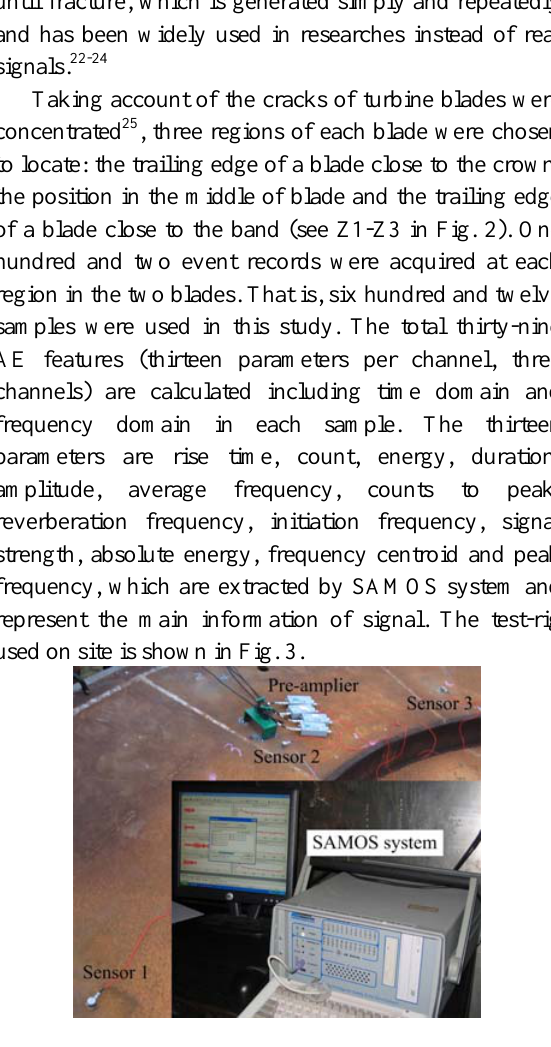
Fig. 3 AE acquisition system employed on-site (ii) Feature extraction